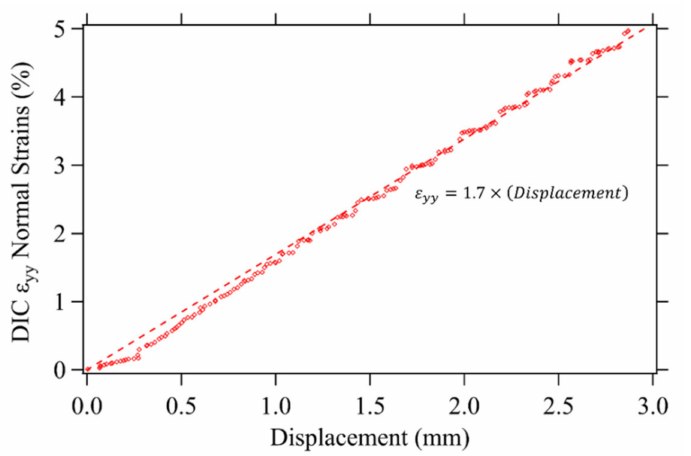
Figure 4. DIC mean ε yy strain versus load frame displacement. A linear fit establishes the coversion relation between these